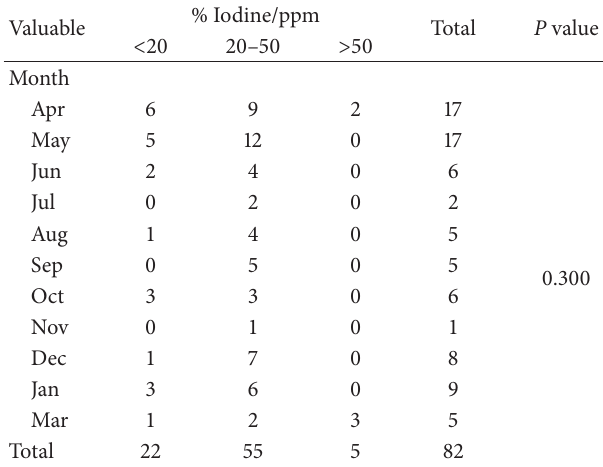
Table 2: Monthly salt sampling frequencies and their gamma iodine